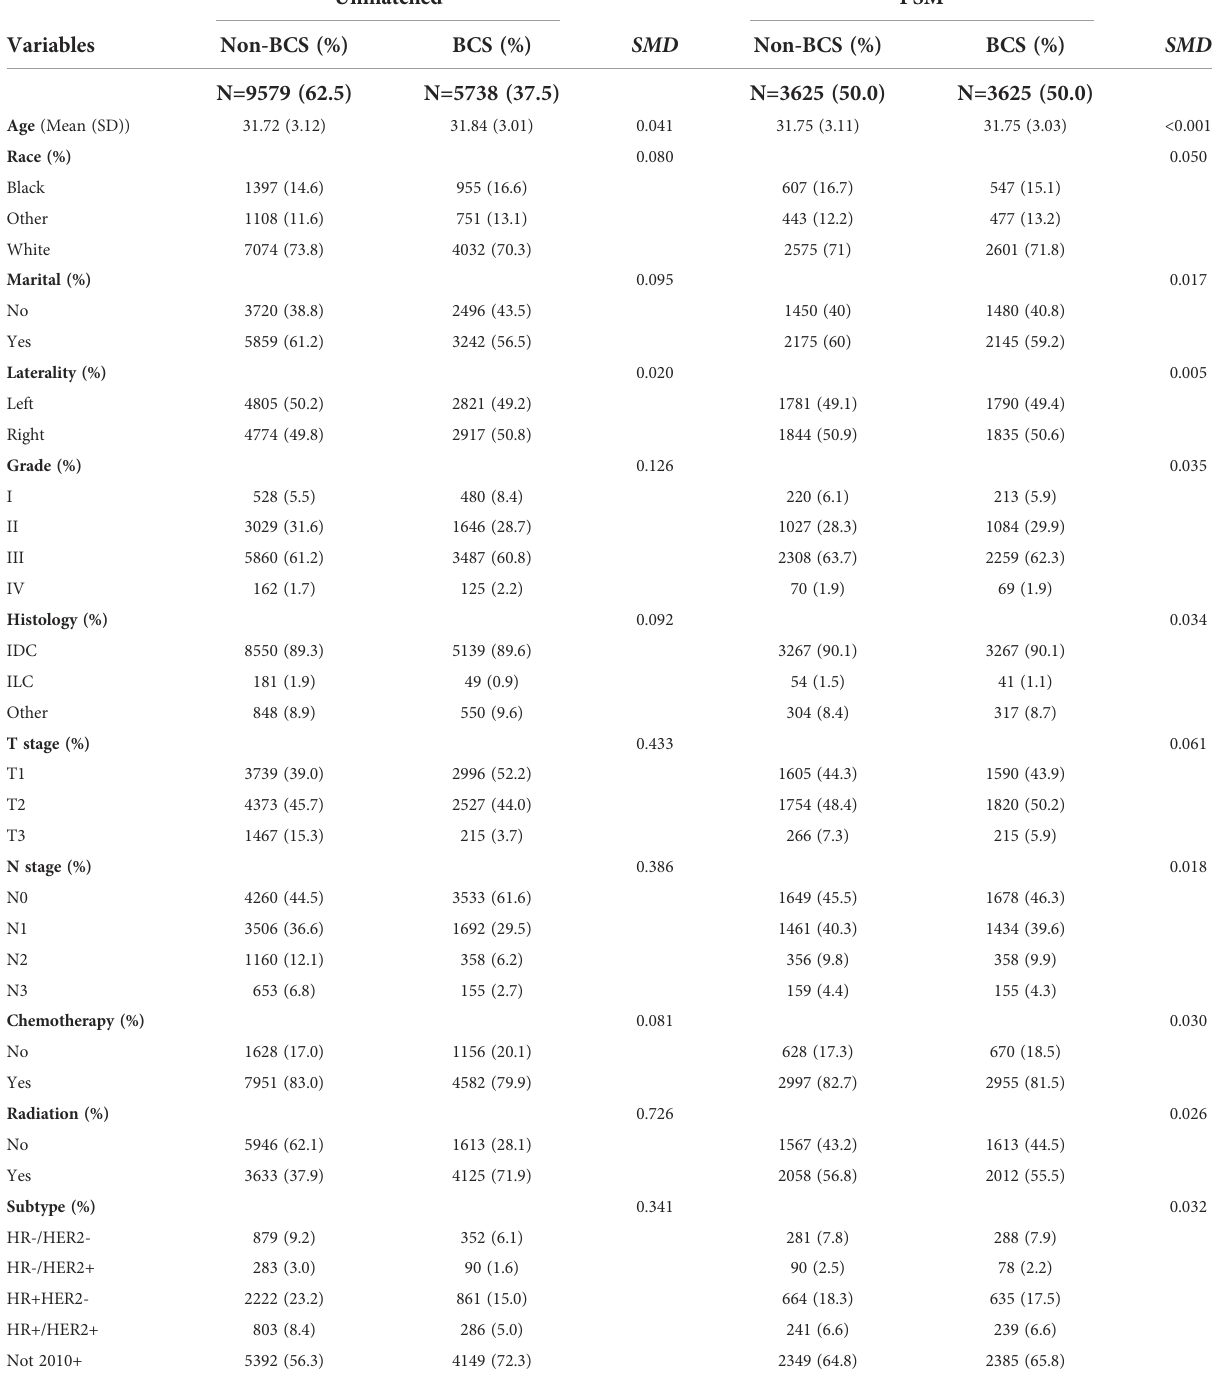
TABLE 1 Clinical and pathological characteristics for breast cancer patients before and after